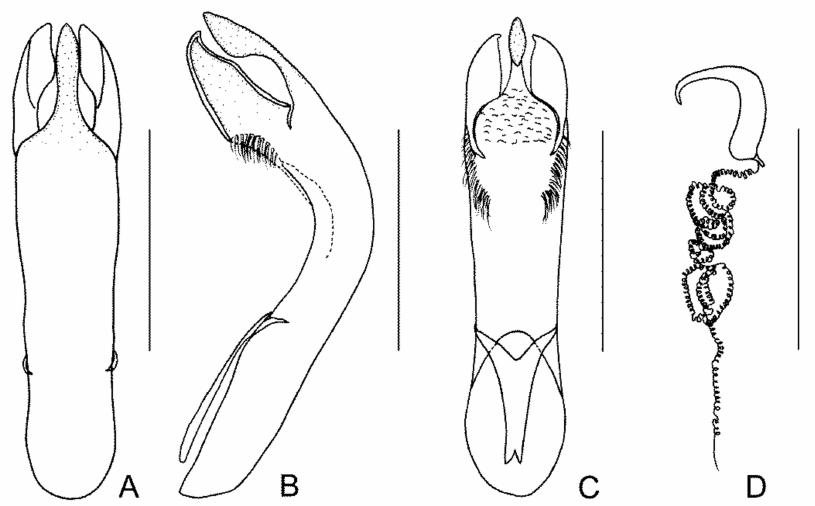
Figure 34. Cryptocephalus ( Burlinius ) shaowuanus Gressitt & Kimoto, 1961: ( A ) dorsal view of aedeagus; ( B ) lateral view of aedeagus; ( C ) ventral view of aedeagus; ( D ) spermatheca (Scale bars: 0.5 mm). The measurements are BL = 2.75 mm, BW = 0.63 mm, HL = 0.71 mm, HW = 0.73 mm, PL = 0.85 mm, PW = 1.38 mm, EL = 1.95 mm, AL = 1.01 mm, AW = 0.18 mm, and SL = 0.33